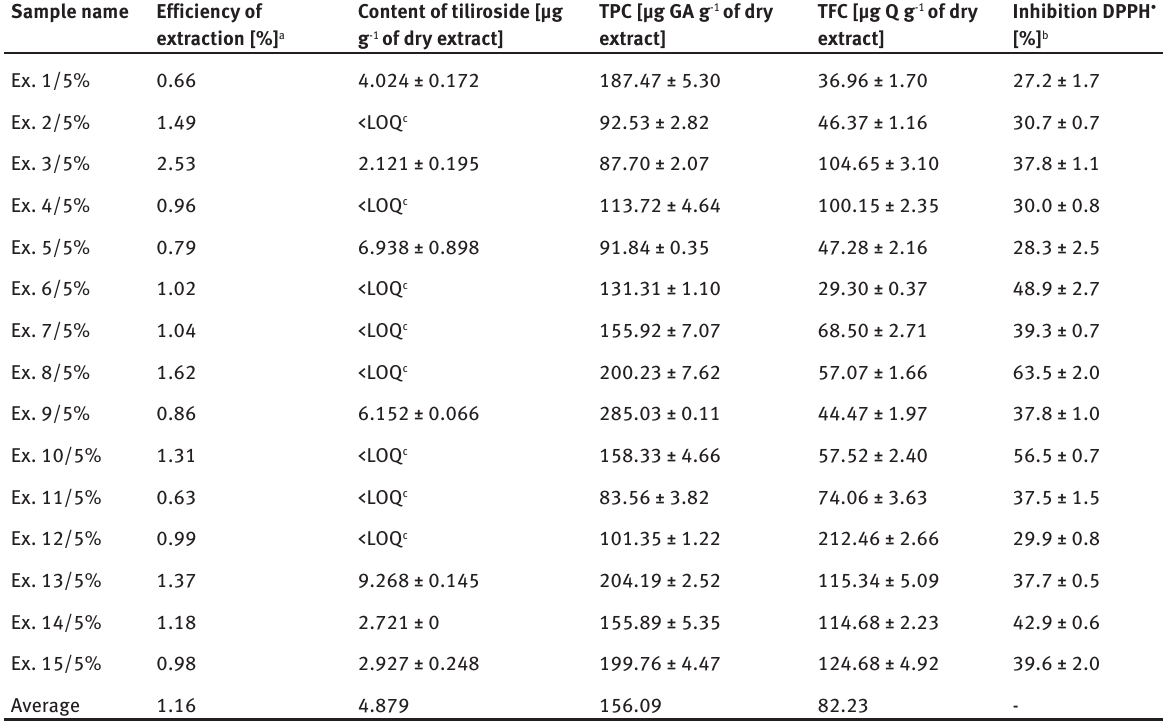
Table 5: Efficiency of extraction, content of tiliroside, TPC, TFC and antioxidant activity of SC-CO Tilia L.